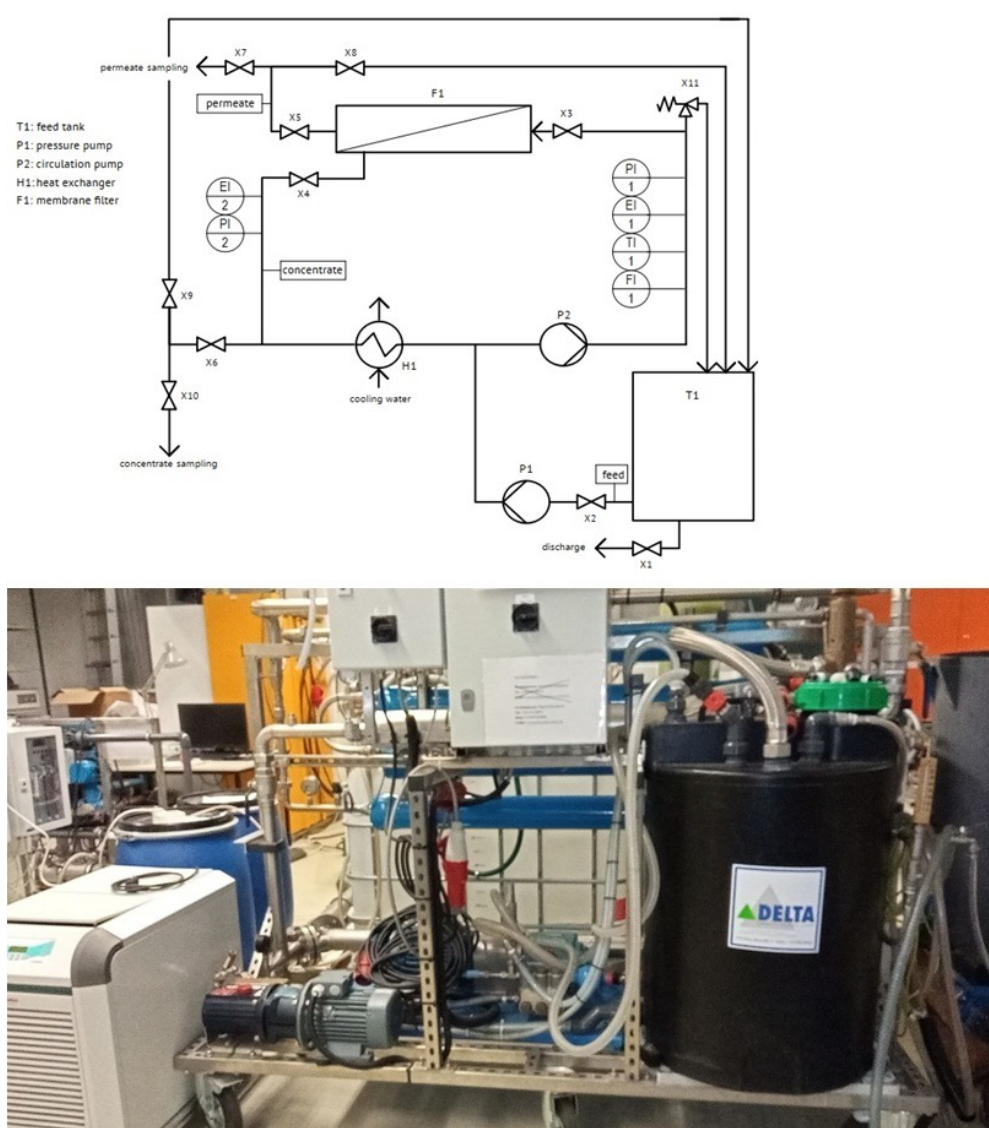
Figure 4. Reverse osmosis bench-scale